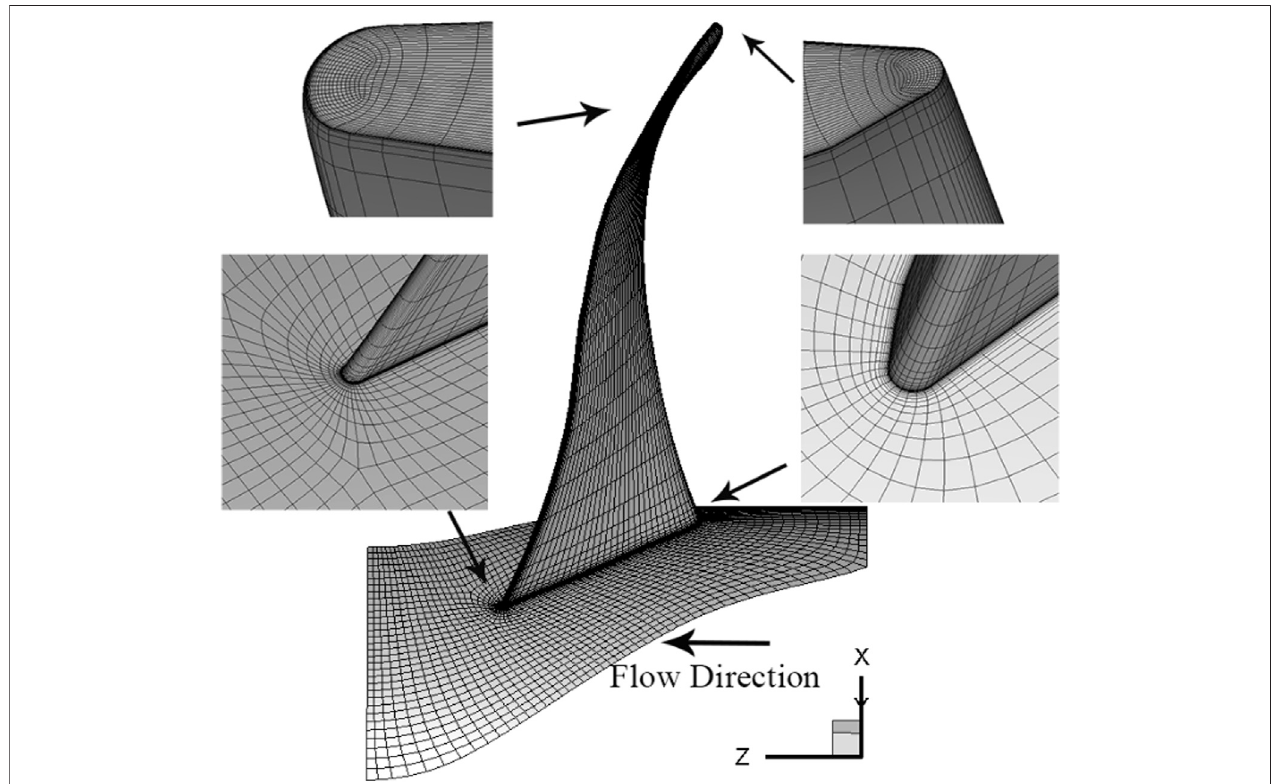
FIGURE 3 | Computational mesh of forward-swept fan.